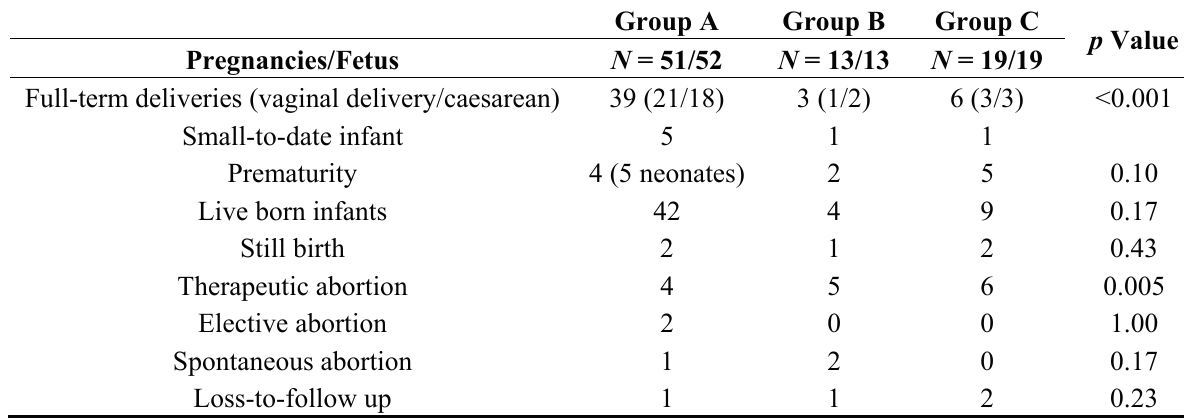
Table 2. Fetal outcome of the 83